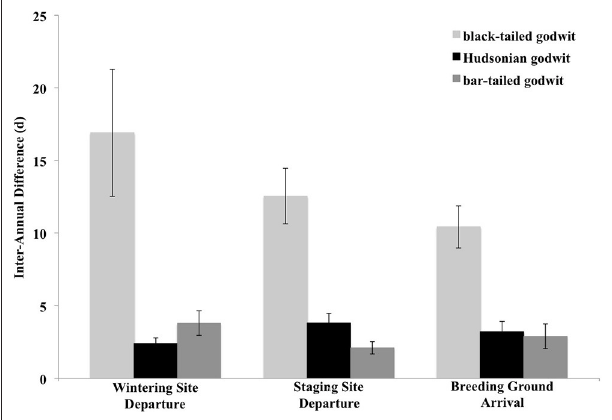
FIGURE 2 | Intra-individual variation in the timing of northward migration among individual black-tailed ( n = 92), Hudsonian ( n = 26), and bar-tailed godwits ( n = 9). Data for Hudsonian and bar-tailed godwits were taken from Conklin et al. (2013) and Senner et al. (2014), respectively. Error bars represent one standard deviation from the